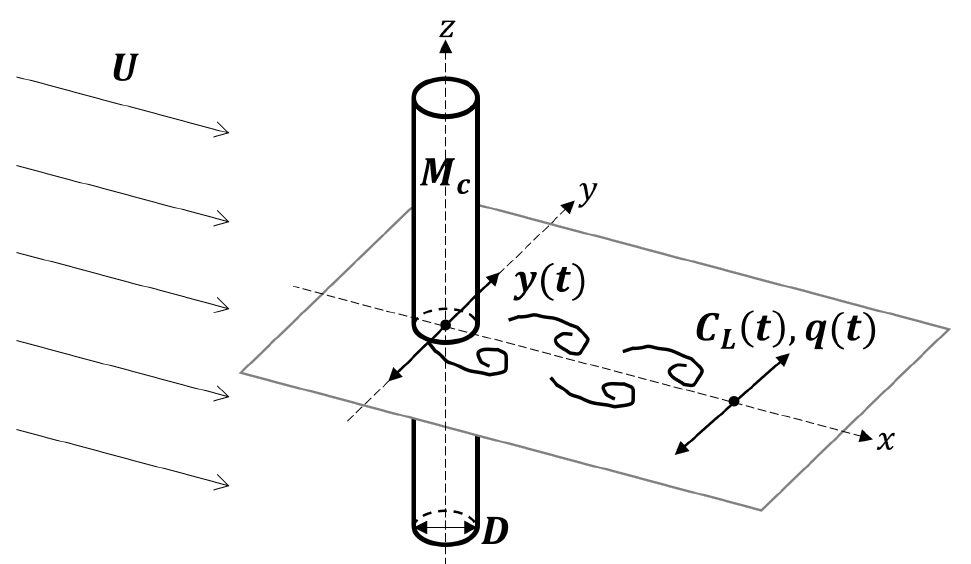
Figure 3. A schematic model of an elastically mounted circular cylinder undergoing cross-flow VIV due to aerodynamic fluid forces acting on the oscillating